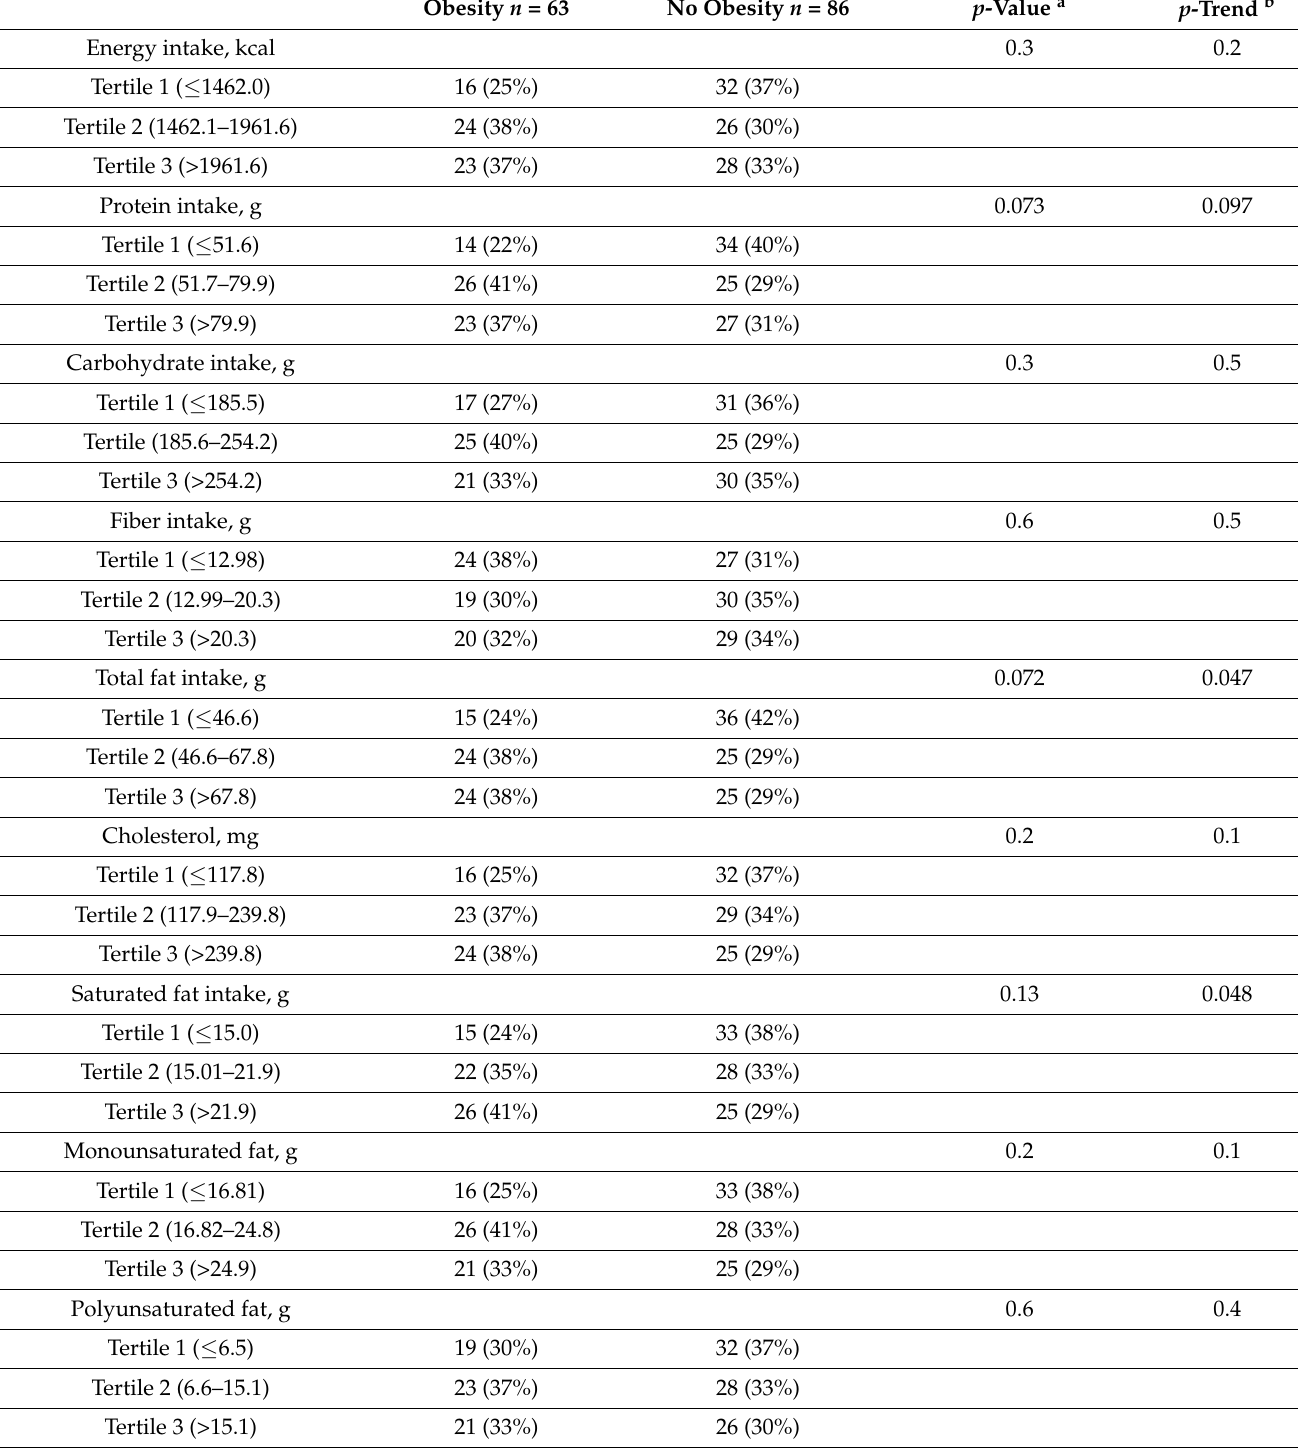
Table 3. Differences in dietary intake of children aged 10–12 years between those with and without obesity. Obesity n = 63 No Obesity n =